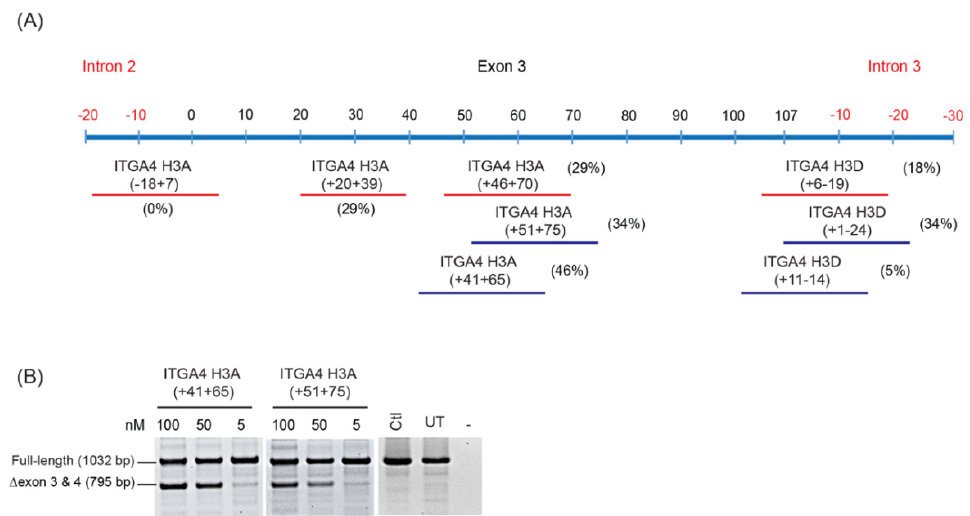
Figure 4. ( A ) RT-PCR analysis of ITGA4 transcripts demonstrating refinement of splice switching AOs targeting ITGA4 exon 3. Oligomers tested in the first screen are indicated by red lines and the micro-walked AOs tested in the second screen are represented by blue lines. Levels of exon skipping after transfection at 100 nM are indicated in brackets. ( B ) Comparison of two AOs that induce skipping of ITGA4 exon 3 and 4 at various concentrations (100, 50, and 5 nM). Ctl; control AO that does not anneal